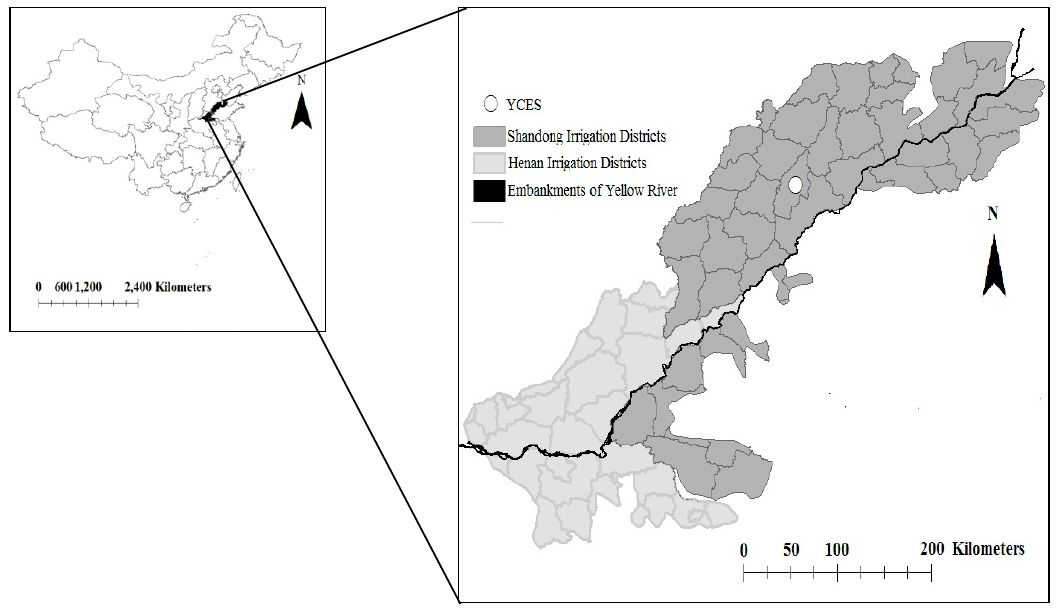
Figure 1. Study area along the lower reach of the Yellow River. YCES is the location of 32 experimental plots.